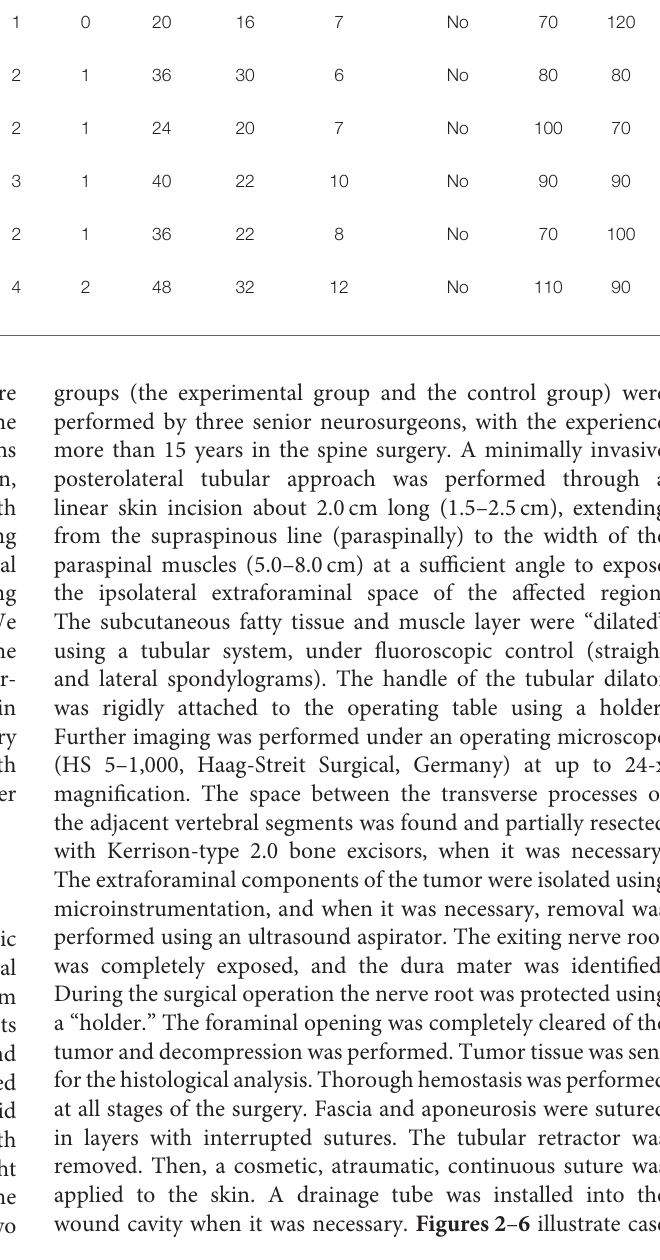
Type of a tumor according to Eden’s classification